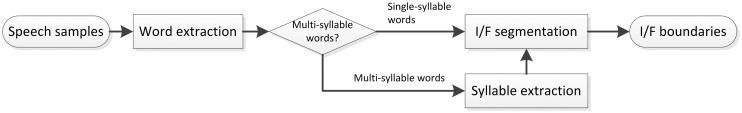
The flowchart of automatic initial and final segmentation system in cleft palate speech.